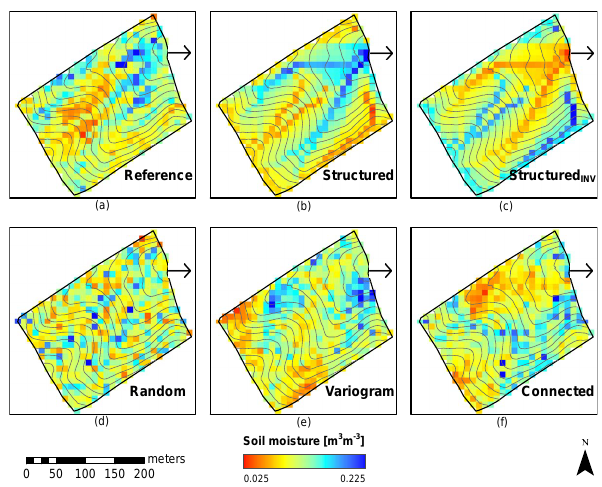
Fig. 2. Antecedent soil moisture maps for Marbaix, 15 April 2009, used as an input in the hydrologic model with measured grided val- ues (a) , measured values rearranged according the TWI (b) , mea- sured values inversely rearranged according the TWI (c) , randomly permuted values (d) , simulated values using a variogram (e) and connected simulated values (f) . The outlet location and direction are indicated with an